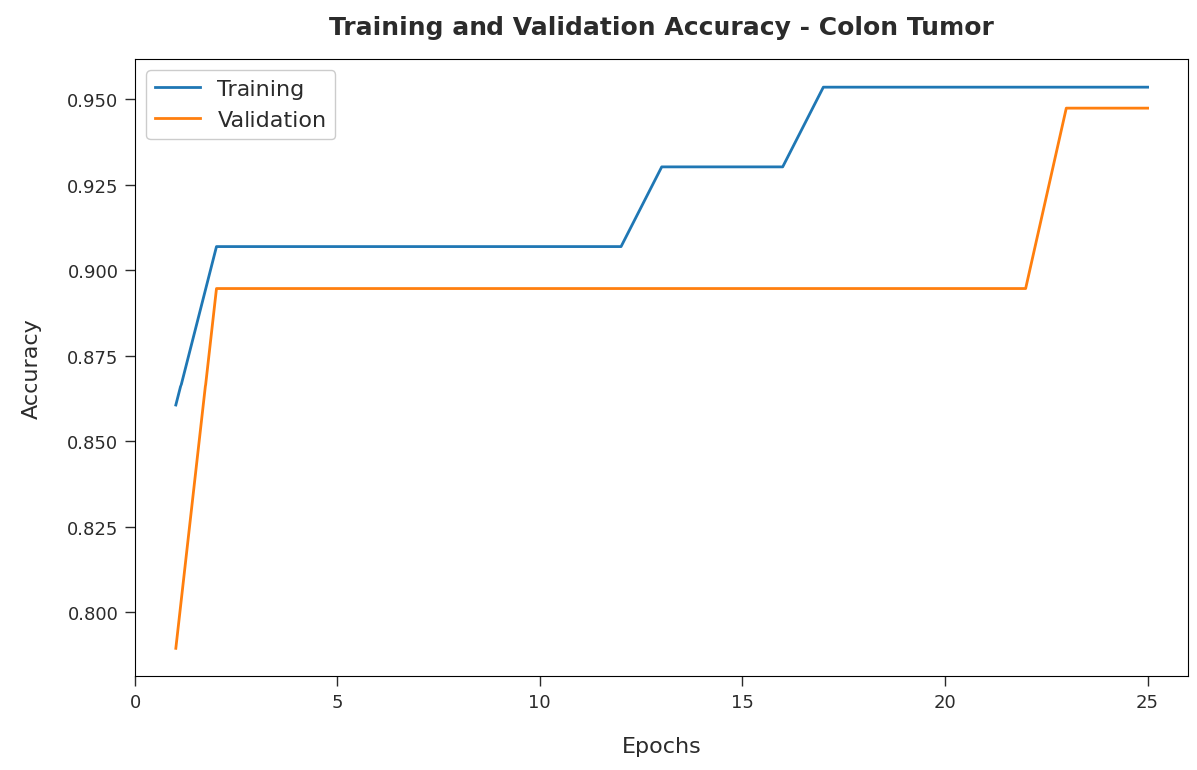
Figure 7. Accuracy analysis of RFODL-MGEC technique on colon tumor dataset.